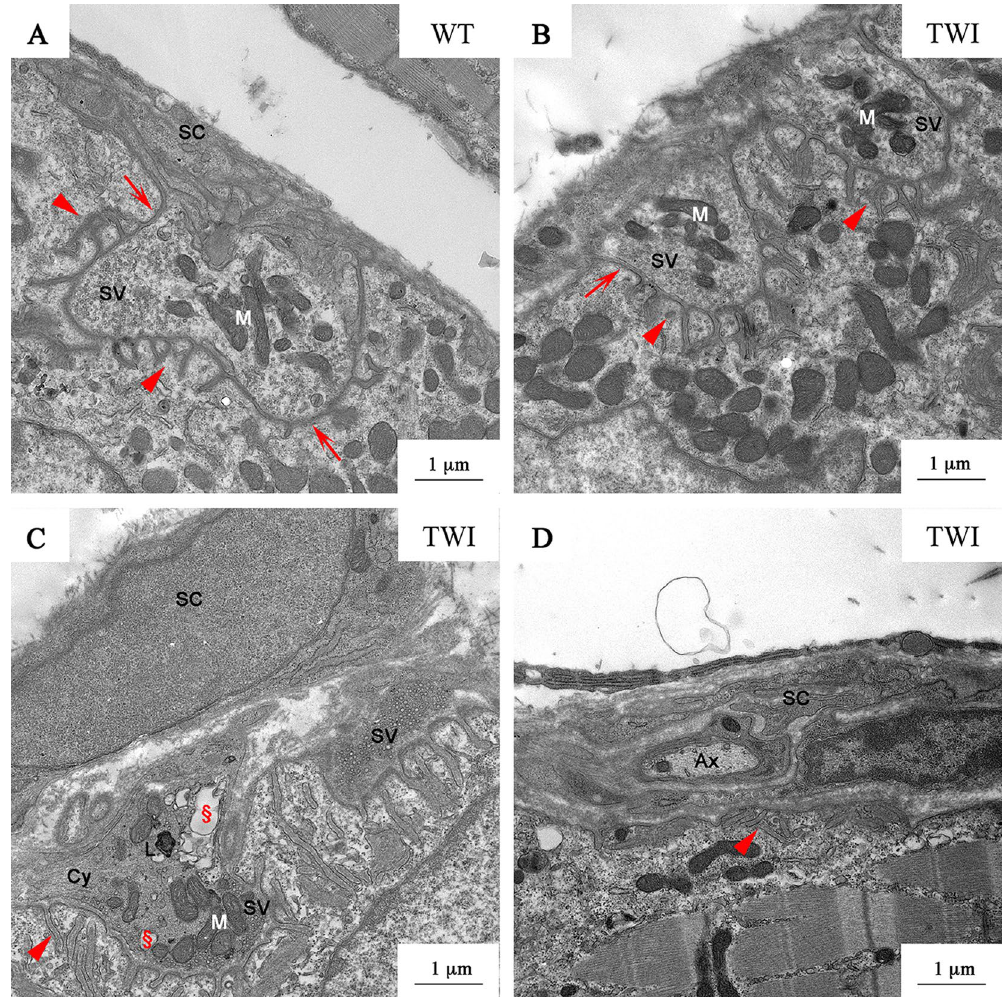
Figure 9. P30 neuromuscular junctions in gastrocnemius muscle. ( A ) NMJ in P30 WT gastrocnemius. SC: Schwann cell processes; SV: synaptic vesicles; M: mitochondria. Arrows and arrowheads indicate the primary and secondary folds respectively. ( B ) P30 TWI gastrocnemius NMJ type 1. ( C ) NMJ type 2; Cy: cytoskeleton elements; §: damaged organelles; L: lytic organelles. ( D ) Representative image of denervated NMJ (type 3) in TWI mice. Ax: